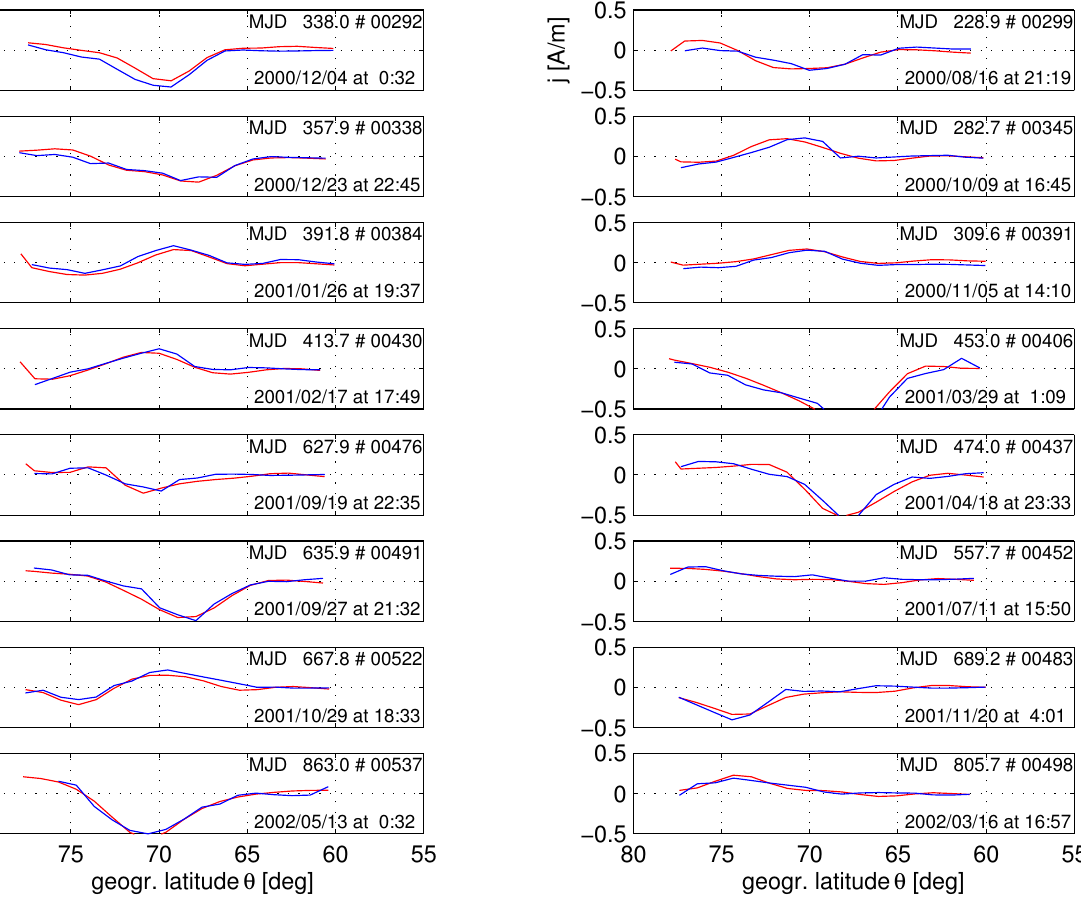
Fig. 7. Comparison of the current densities derived from CHAMP (red lines) and IMAGE ground-based measurements (blue lines) between Aug 2000 (MJD 215) – May 2002(MJD 880) on N/S profiles across the IMAGE array (60 ◦ –80 ◦ N geographic latitudes). Left side: the satellite crossed the region on ascending tracks; right side: on descending tracks. MJD = Modified Julian Days (format see Figure 2).